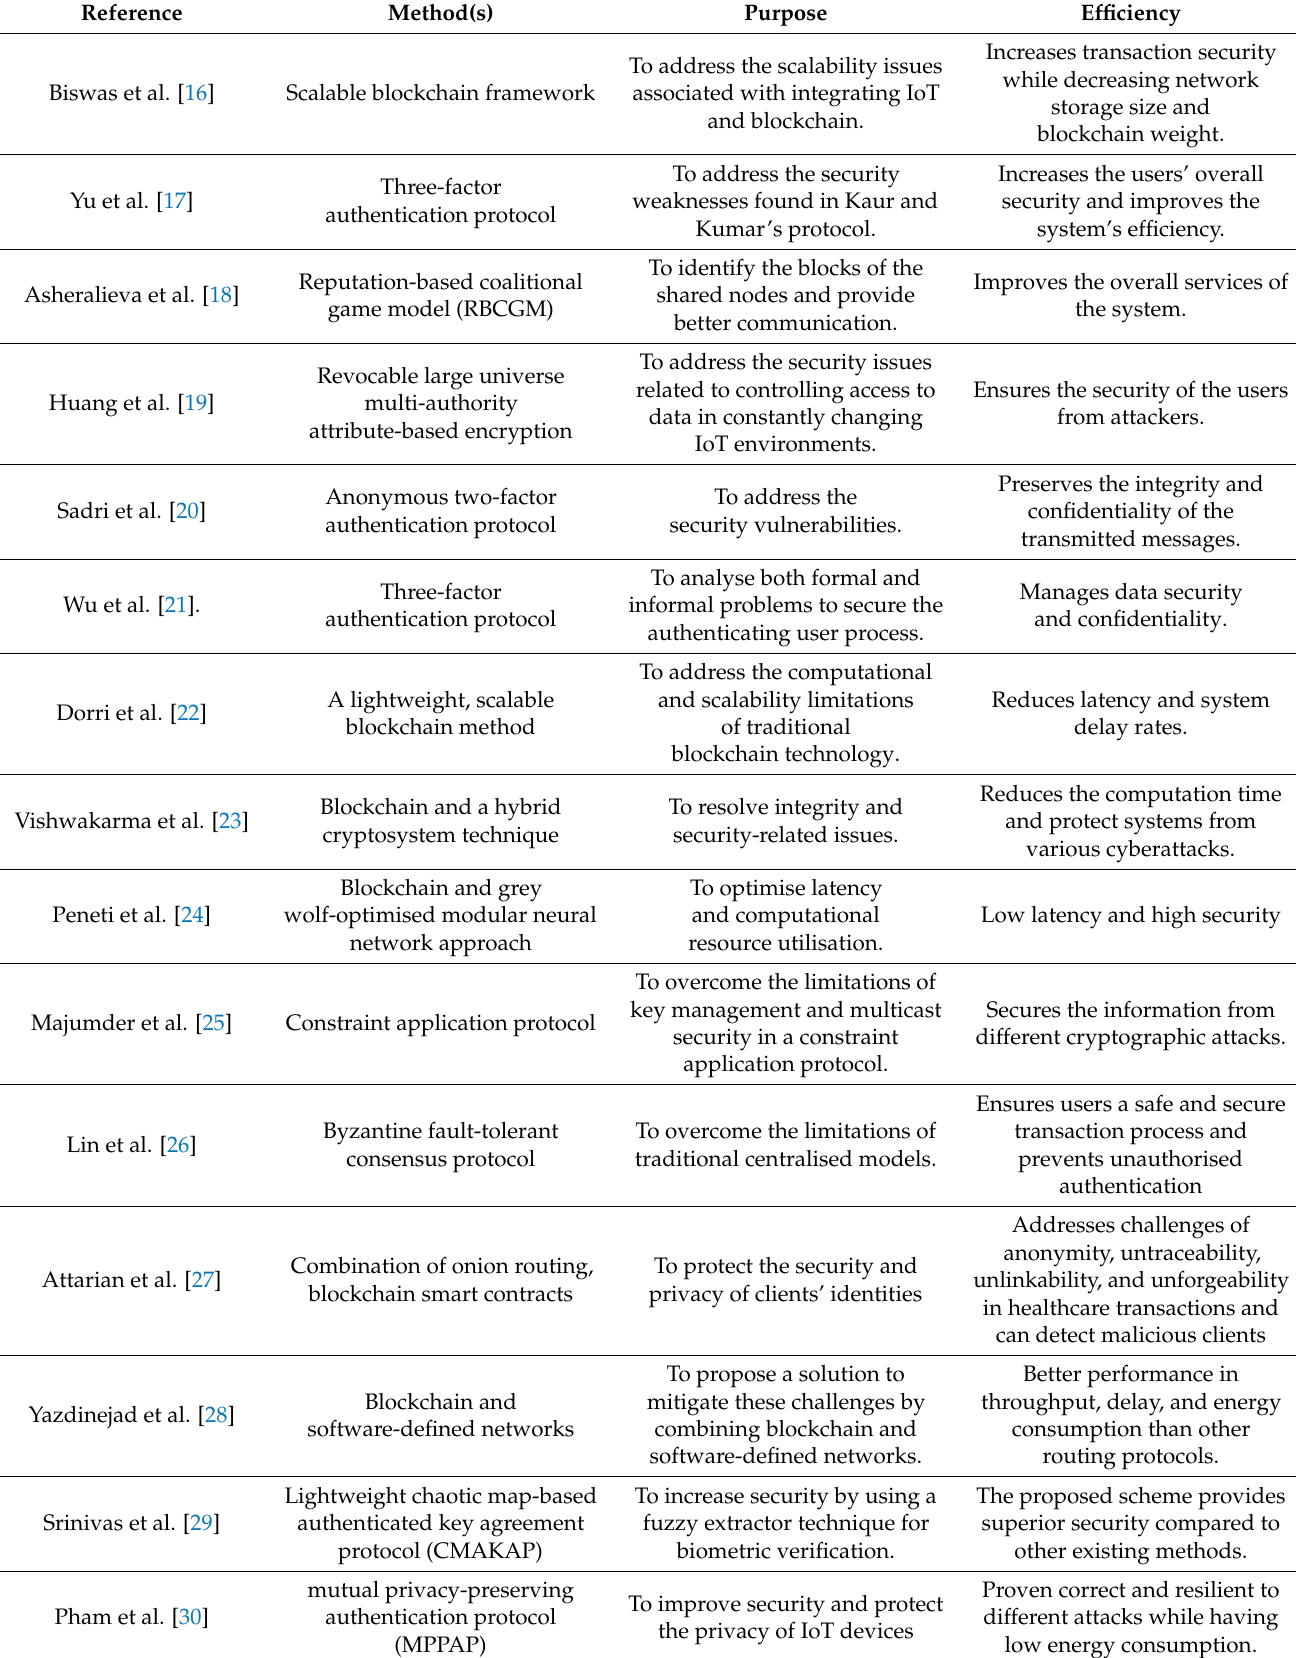
Table 1. Summary of the related